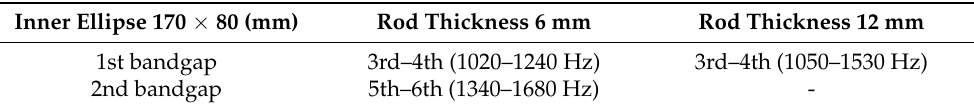
Table 7. Band gaps for a grid with homogeneous microstructure. Inner ellipse 170 × 80. Inner Ellipse 170 × 80 (mm)